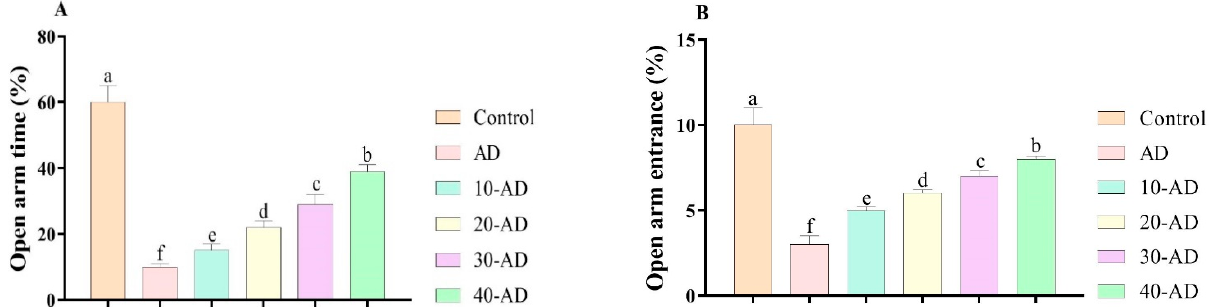
Figure 2. The effects of sake yeast on plus-maze behaviors in rats with Alzheimer. ( A ) Open arm time and ( B ) Open arm entrance. Superscript symbols (a–f) show significant differences between groups.